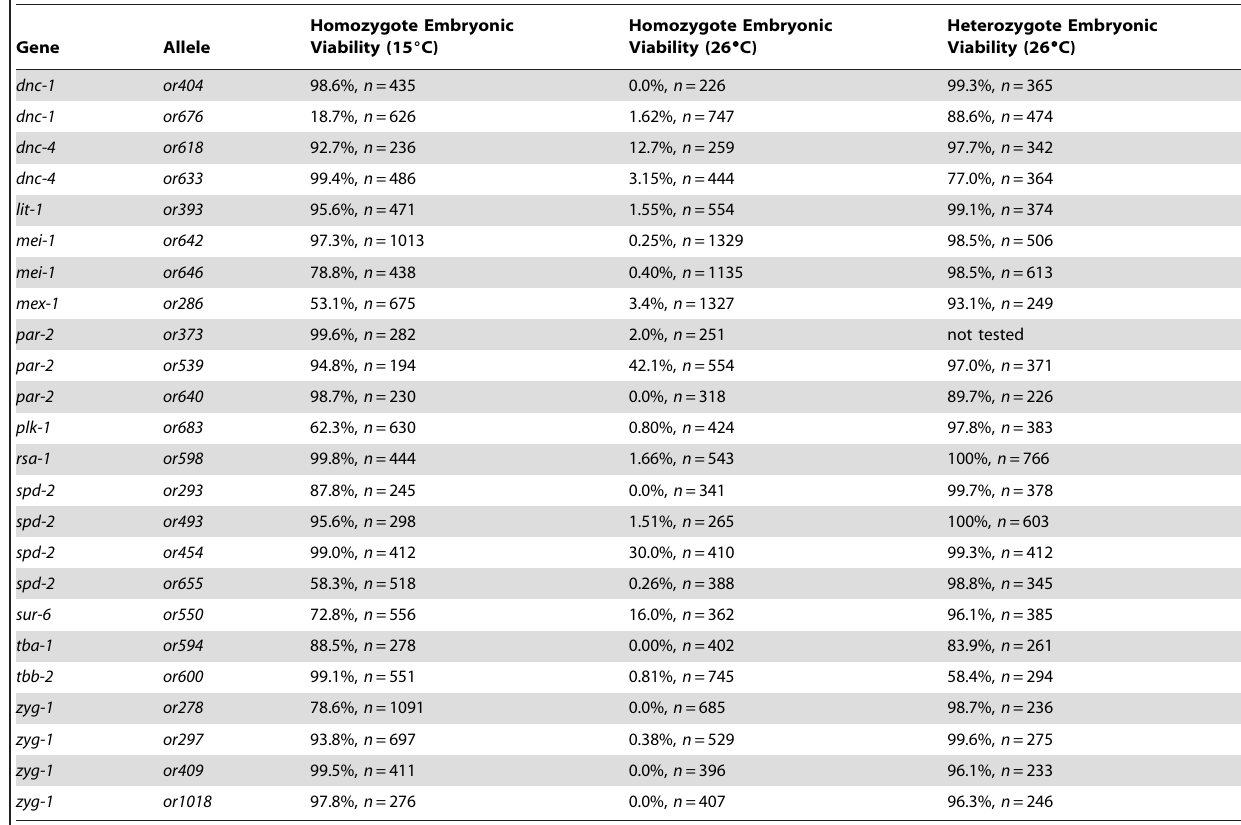
Table 1. Embryonic lethality of the TS mutants.